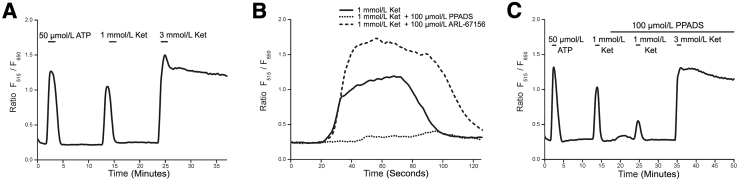
Treatment of normal (nonimmortalized) human urothelial (NHU) cells with ketamine (Ket) resulted in elevation of cytosolic [Ca2+]. A: The addition of 1 mmol/L ketamine (noncytotoxic) to a culture of NHU cells produced a transient increase in cytosolic [Ca2+], whereas exposure to 3 mmol/L ketamine (cytotoxic) induced a higher [Ca2+] in the cytoplasm, which did not return to a normal baseline. B: The role of purinergic receptors in mediating the urothelial response to 1 mmol/L ketamine was investigated by preincubating cultures for 10 minutes in 100 μmol/L pyridoxal-phosphate-6-azophenyl-2′,4′-disulfonate (PPADS; purinergic receptor inhibitor) or ARL-67156 (ecto-ATPase inhibitor). PPADS (dotted line) almost completely blocked the calcium transient observed after addition of 1 mmol/L ketamine to NHU cells, whereas ARL-67156 (dashed line) increased both the amplitude and duration of the transient. C: Preincubating cultures in PPADS was not sufficient to inhibit the [Ca2+] increase triggered by 3 mmol/L ketamine. All images are traces representative of triplicate experiments.